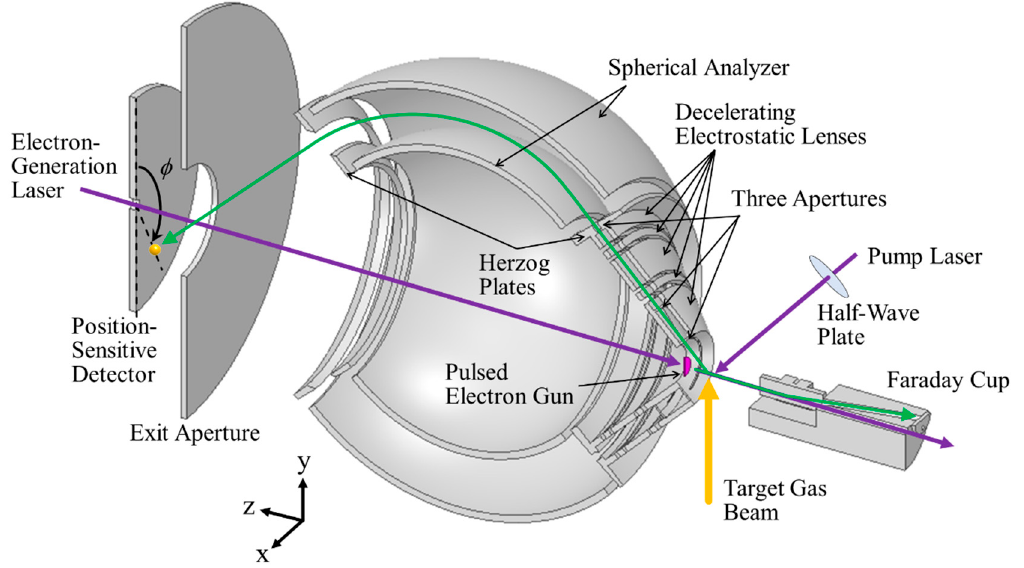
Figure 3. Schematic of a multichannel atomic momentum spectroscopy (AMS) spectrometer.